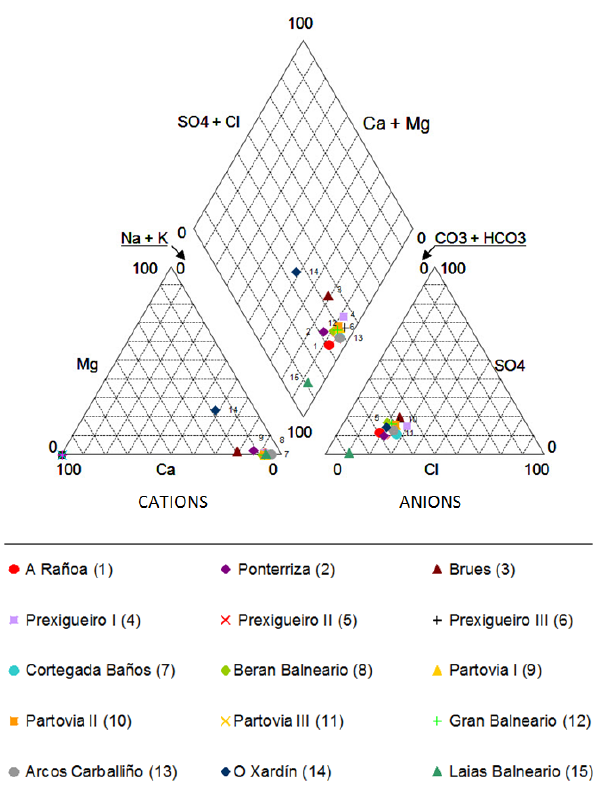
Fig. 2. Hill-Piper diagram of the 15 selected waters from Carballiño. The analytical data represented in the diagram correspond to the sampling campaign on April 2008.